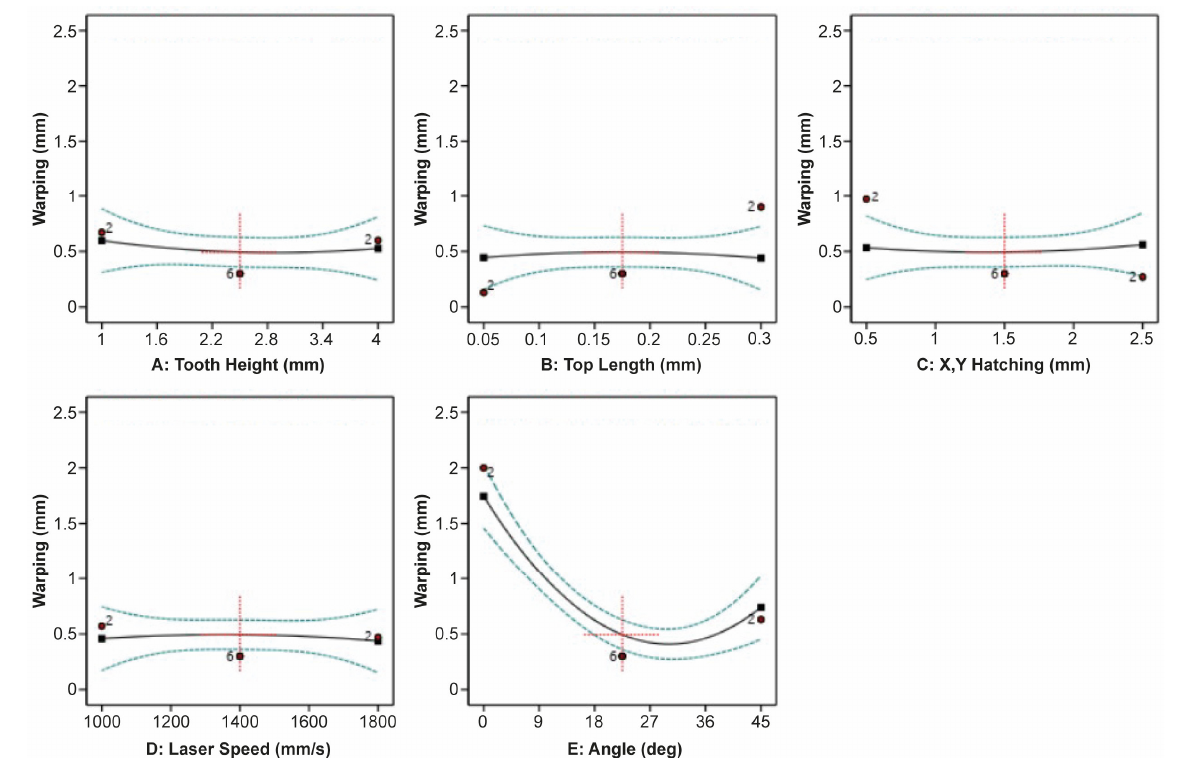
Figure 9. Contour plots of support parameters and Overhang Angle on Support Removal Effort. Figure 10. Main plots of Warping Deformation in Design-Expert 13. Figure 10. Main plots of Warping Deformation in Design-Expert 13.